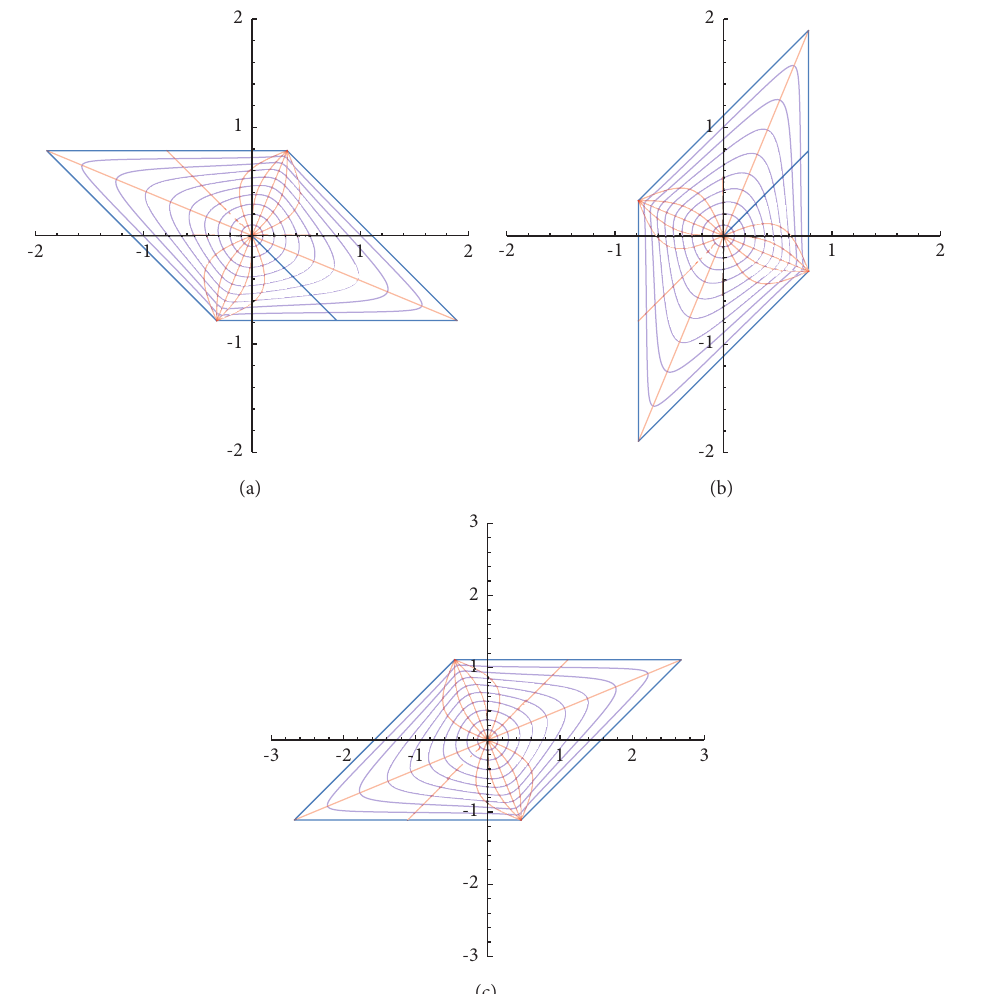
Figure 3: Images of D under f